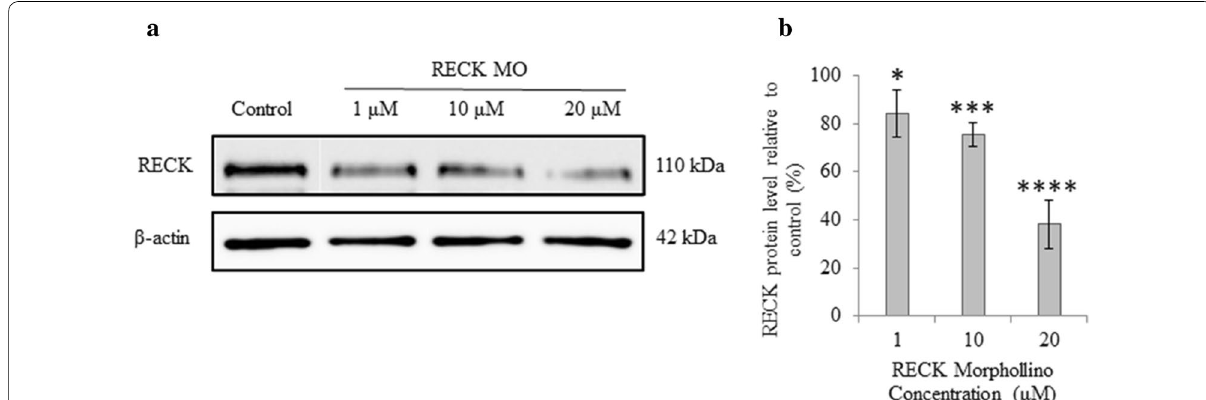
Fig. 1 Treatment of A6 cells with RECK MO resulted in decreased RECK protein levels. Immunoblot analysis was used to confirm reduction of RECK protein following treatment of A6 cells with RECK MO using Endo-porter delivery reagent. Protein was extracted from cells 48 h following treatment with increasing concentrations of RECK MO. a Knockdown of RECK protein occurred in a dose-dependent manner. β-actin is used as a loading control. b Quantification of protein levels in a were graphed and data is based on 3 biological replicates (mean SD) and normalized to control (set ± to 100%). Data is analyzed via t test; *, p 0.05; ***, p 0.001; ****, p ≤ ≤ ≤